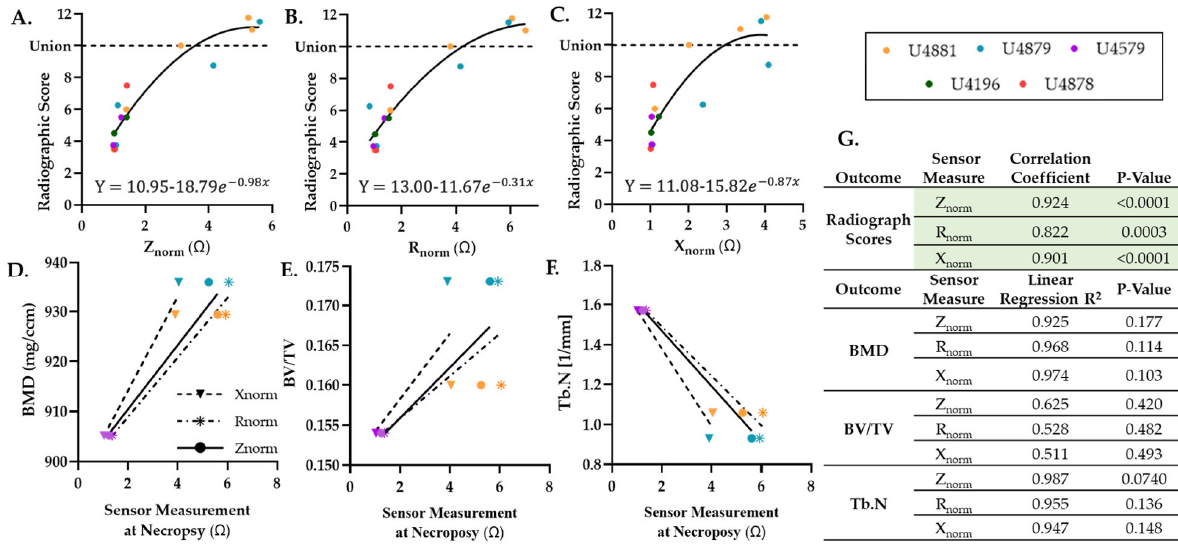
Figure 6. Smart sensors reproduce classic X-ray and µ CT measures. All sensor measurements significantly correlate to ( A – C ) radiographic and ( D – F ) µ CT outcomes. ( G ) Spearman correlation coefficients and goodness of fit to a linear regression (R 2 ) between each measurement. Green coloring highlights statistical significance of P < 0.05.